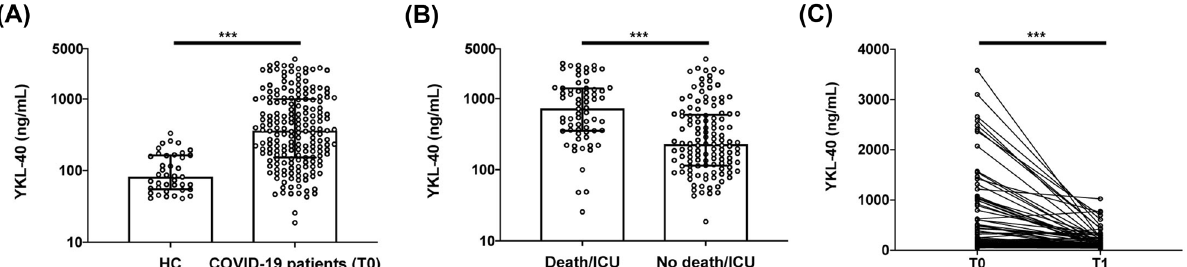
Figure 1. CHI3L1 plasma levels in COVID-19 patients and healthy controls. CHI3L1 plasma levels in: ( A ) age- and sex-matched healthy controls (HC) and COVID-19 patients at hospital admission (COVID-19 patients T0); ( B ) COVID-19 patients transferred to ICU or who died (Death/ICU) and patients with favorable outcome (No death/ICU); ( C ) eighty survivors at hospital admission (T0) and one month after discharge (T1). *** <